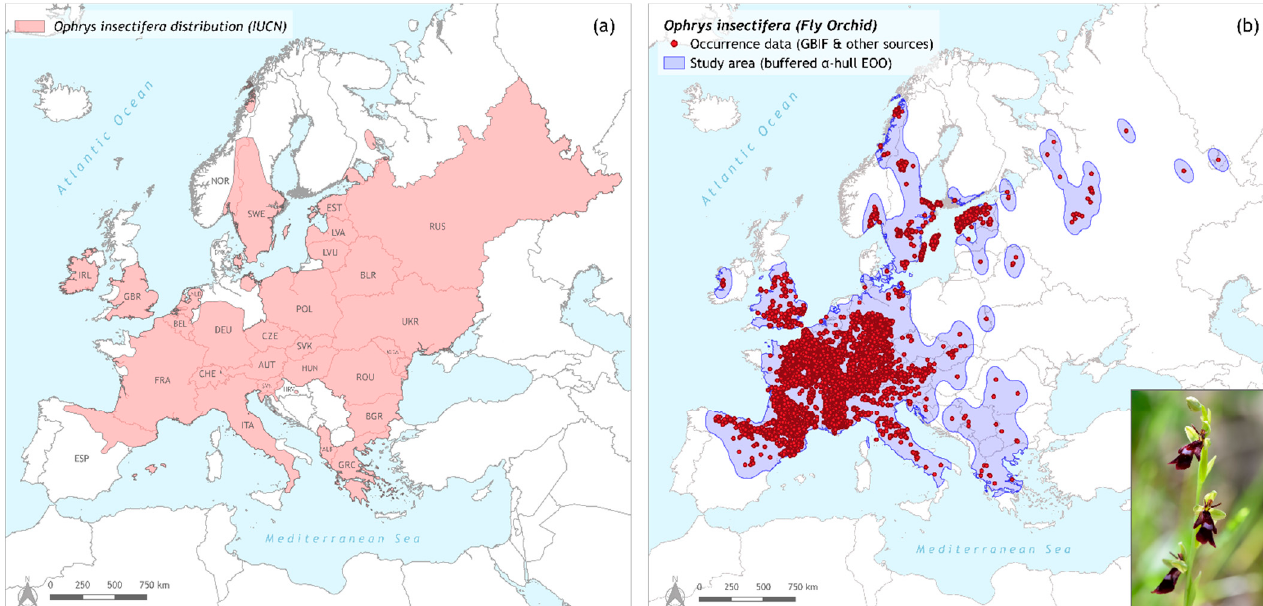
Figure 1. ( a ) Ophrys insectifera distribution map, compiled with data downloaded from IUCN [53], ( b ) map including the total occurrence data for O. insectifera retrieved from GBIF and other sources, and the study area defined as a buffered α -hull extent of occurrence (EOO). Both maps are designed in QGIS v.3.18 ‘Zürich’, using ETRS89—Lambert Conformal Conic Coordinate Reference System. Photo of the species taken in June 2019 at Mt. Tzoumérka (Epirus, NW Greece).